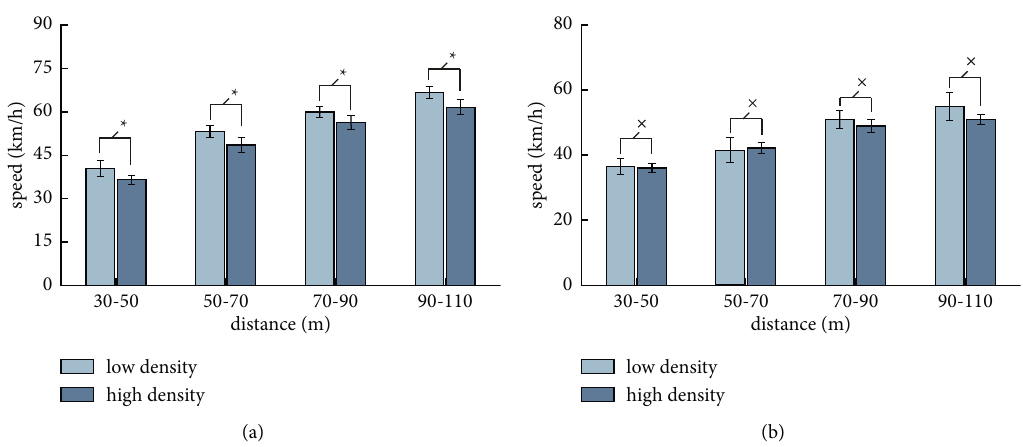
Figure 14: AVOVA results for traffic density on the second approach speed. (a) Freedom. (b)